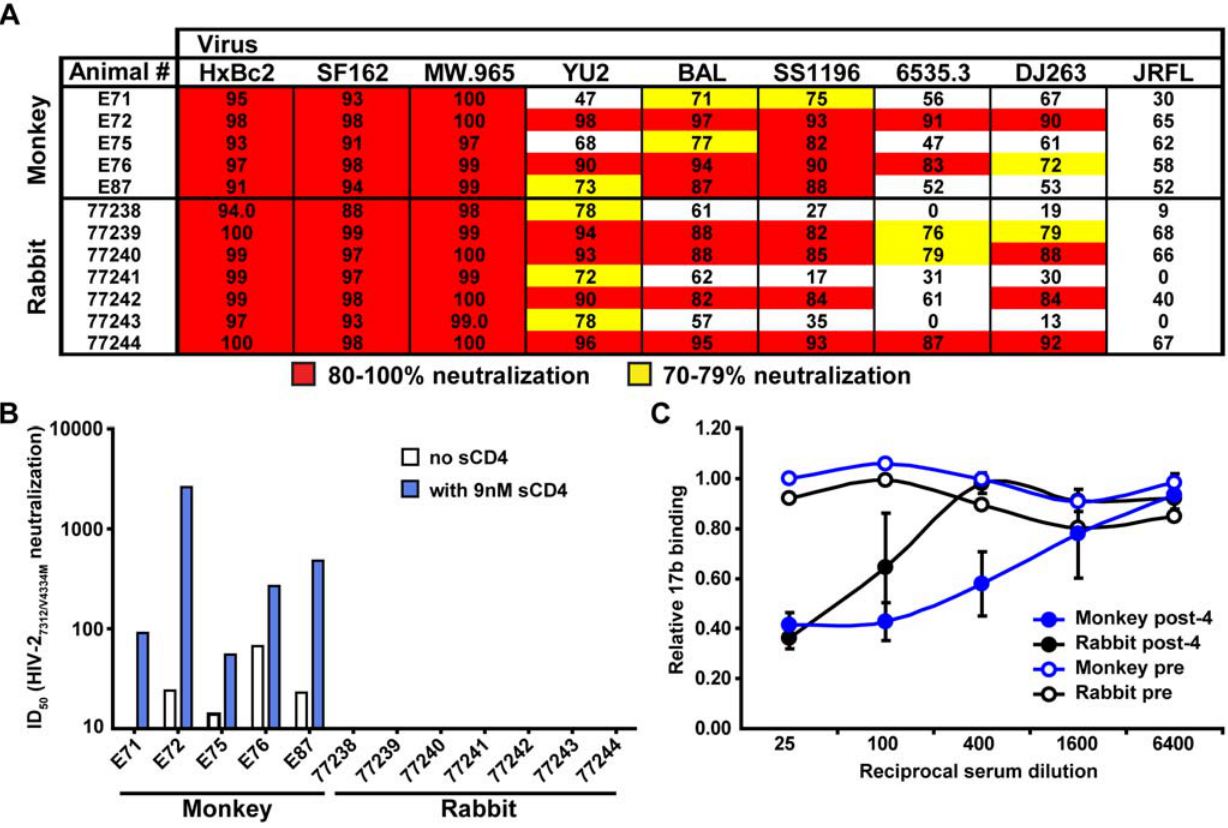
Figure 4. HIV-1 and HIV-2 neutralization. (A) Overall neutralization activity against nine different HIV-1 Env pseudotyped viruses in serum samples from monkeys and rabbits following 4 immunizations with the YU2 gp140-F trimers. Sera were screened at a 1:5 dilution (except against MW.965, which was done at a 1:10 dilution of the sera) for neutralization activity. Neutralization between 70 and 79% is indicated in yellow, while neutralization between 80 and 100% is indicated in red. Pre-bleed serum sample effects on viral entry were negligible; BSA adjuvant control animals and MuLV pseudotyped virus were also included as negative controls. (B) Detection of CD4i antibodies in serum samples from immunized cynomolgus macaques and rabbits after 4 immunizations. Serum samples from monkeys and rabbits were titrated for neutralization activity against HIV-2 7312/V434M . Data are presented as the reciprocal dilution of immune serum resulting in a 50% inhibition of entry (ID 50 ) in the absence (white bars) or presence (blue bars) of 9 nM sCD4. (C) A 17b blocking assay was performed using sera elicited from monkeys (blue) and WT rabbits (black). For the assay, the sera were serially diluted in a 96 well format in which the wells were pre-coated with HXBc2 core gp120 glycoproteins. Following washing, biotinylated 17b was added to each well and the ability of the sera to block 17b binding was assessed by